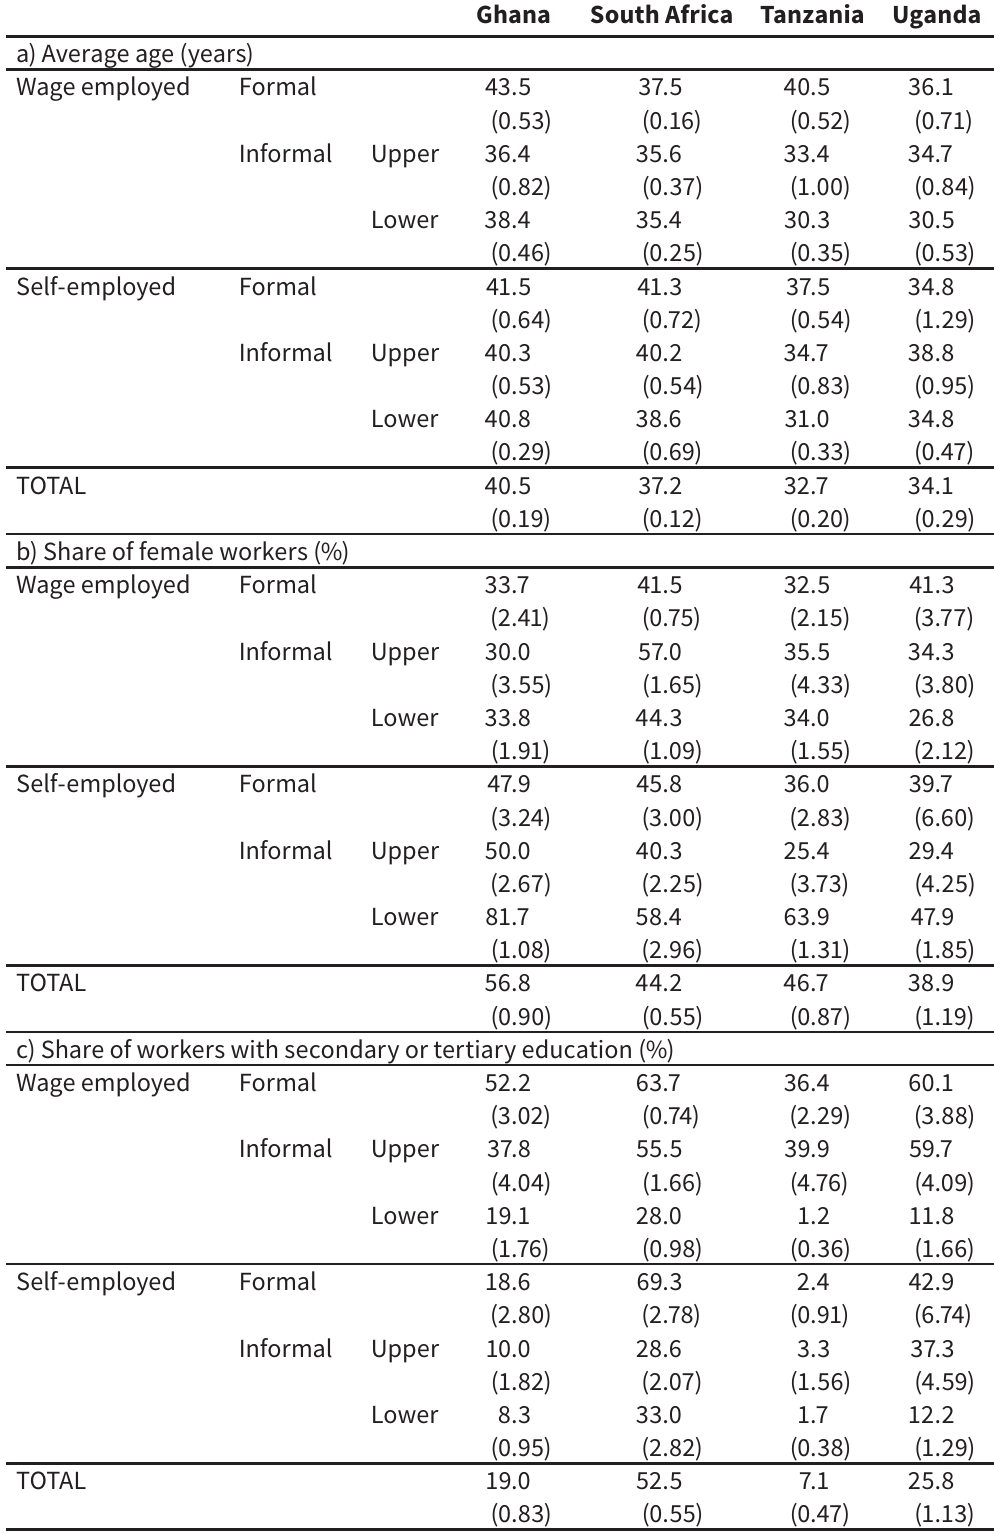
Average worker characteristics by work